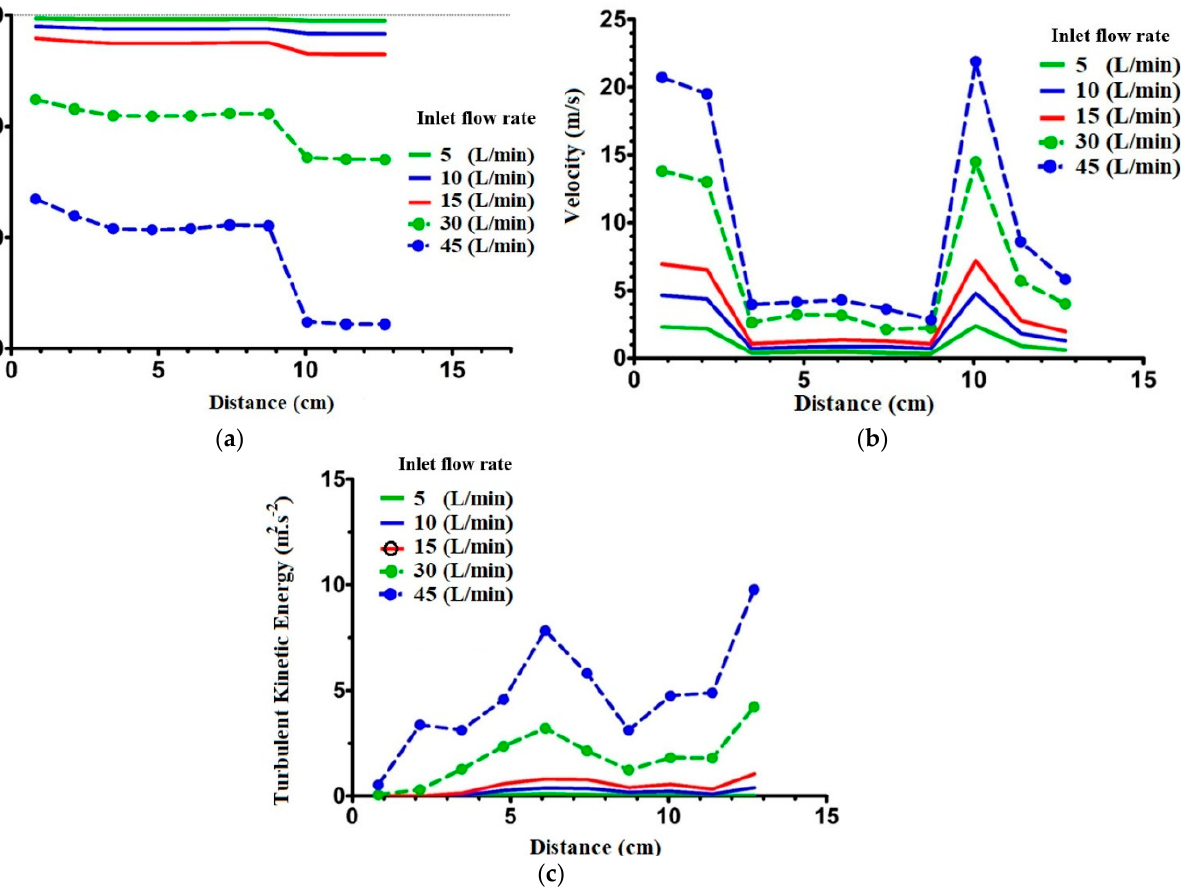
Figure 10. Effect of distance from nasopharynx on ( a ) pressure, ( b ) velocity, and ( c ) turbulent kinetic energy—SST model. energy—SST